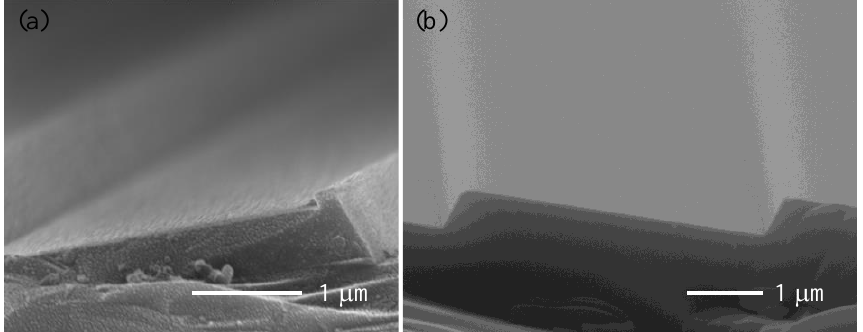
Figure 7. Grating grooves prepared under different grating mask preparation process. ( a ) only using RIE technique; ( b ) combining RIE technique and BOE wet etching technique.